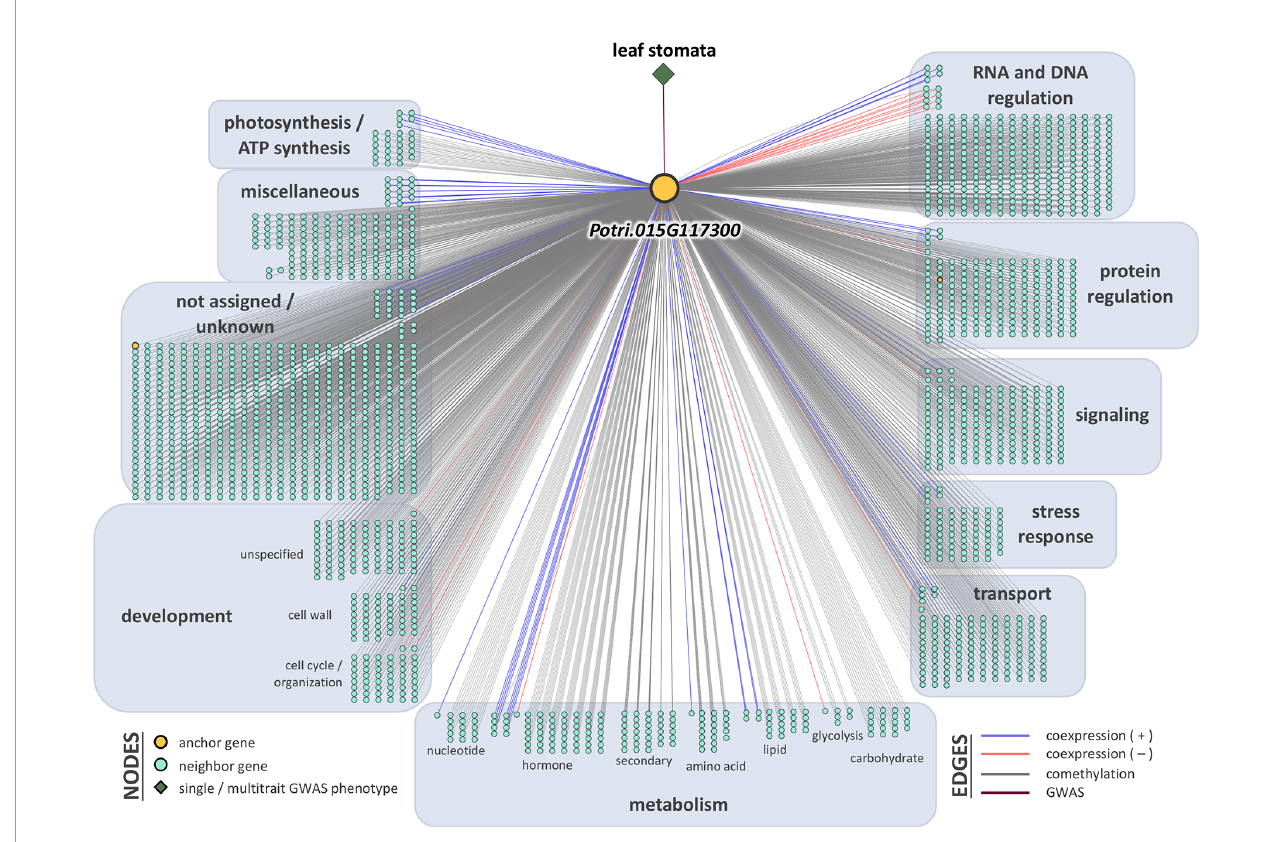
FIGURE 7 | One-hop multi-omic network for the gene Potri.015G117300, which was associated with leaf abaxial stomatal